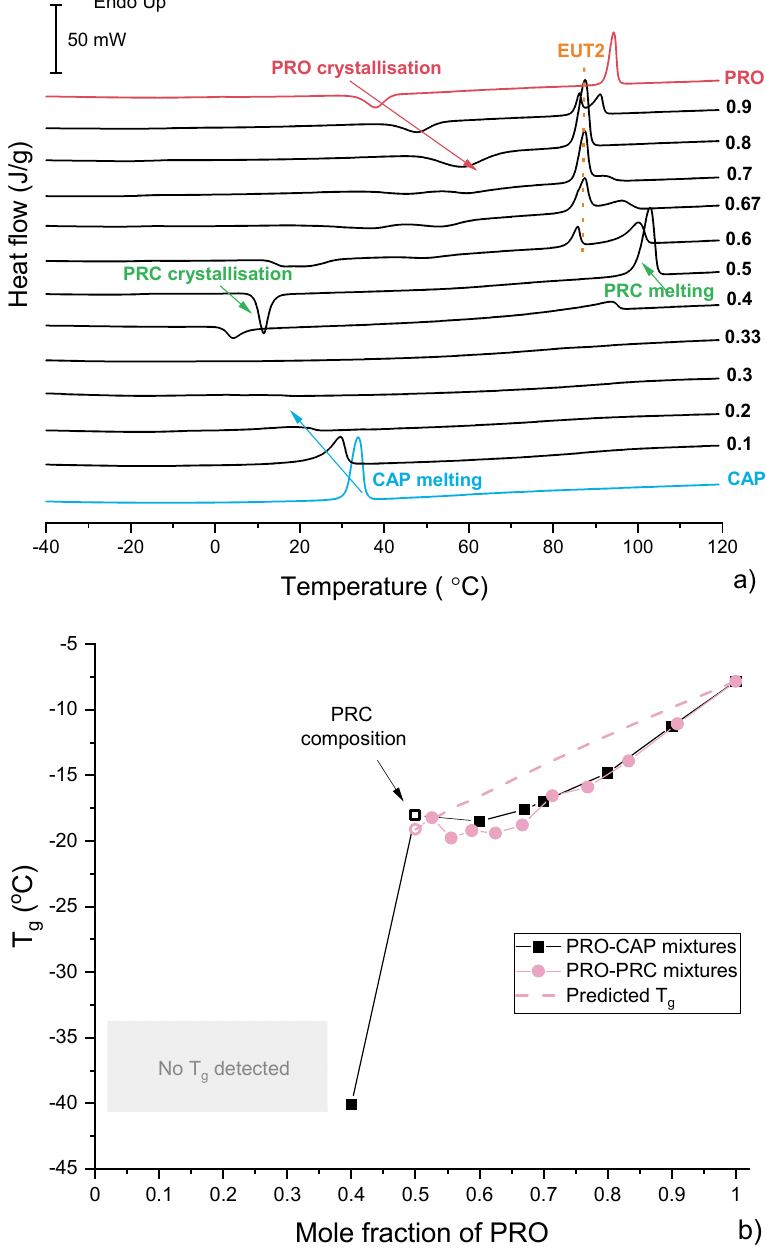
Figure 8. ( a ) DSC traces of PRO-CAP physical mixtures obtained in the second heating cycle. The labels represent mol fraction of PRO. ( b ) Glass transition temperature (T g ) vs. composition relationship for supercooled PRO-CAP (black) and PRO-PRC (pink) mixtures. The predicted T g , shown as a broken pink line, was calculated using the Fox equation [46]. The solid lines are used as a guide for the eye.